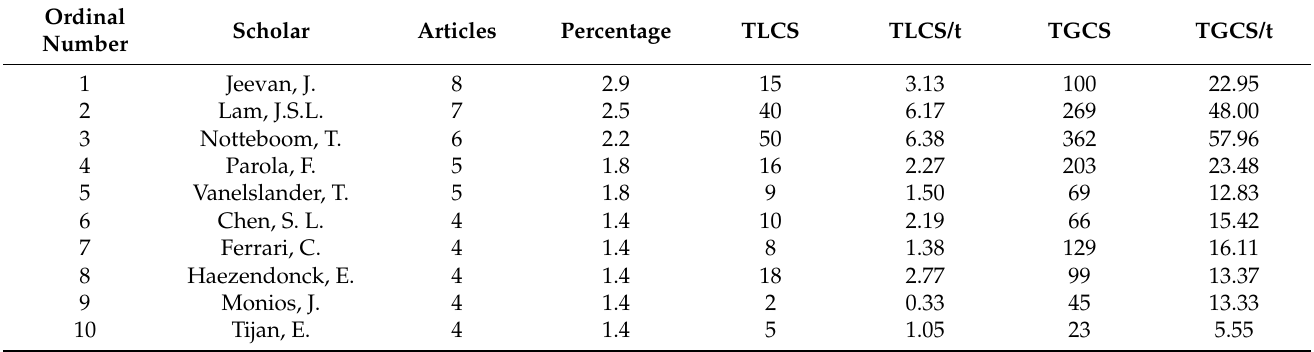
Table 5. The top 10 influential scholars regarding the emerging green port research